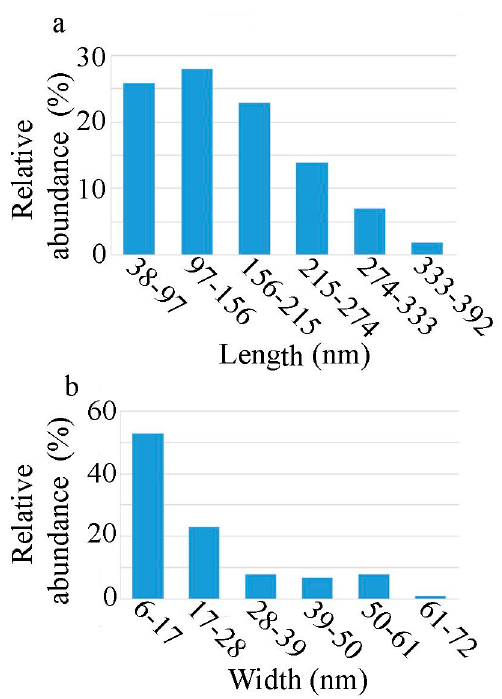
Figure 4. Histograms of the length ( a ) and the width ( b ) of the obtained ZnO nanorods.